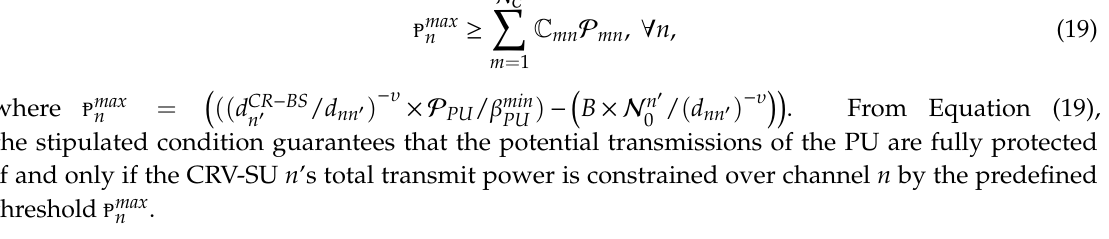
Table 2. List of acronyms.